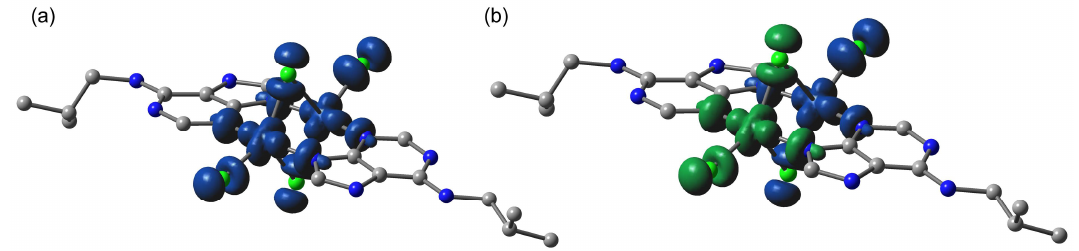
Figure 7. Representation of spin density (contour 0.004 e Å − 3 ) at the high spin ( a ) and low spin ( b ) configurations of 3 . Positive spin represented in blue and negative spin in green.